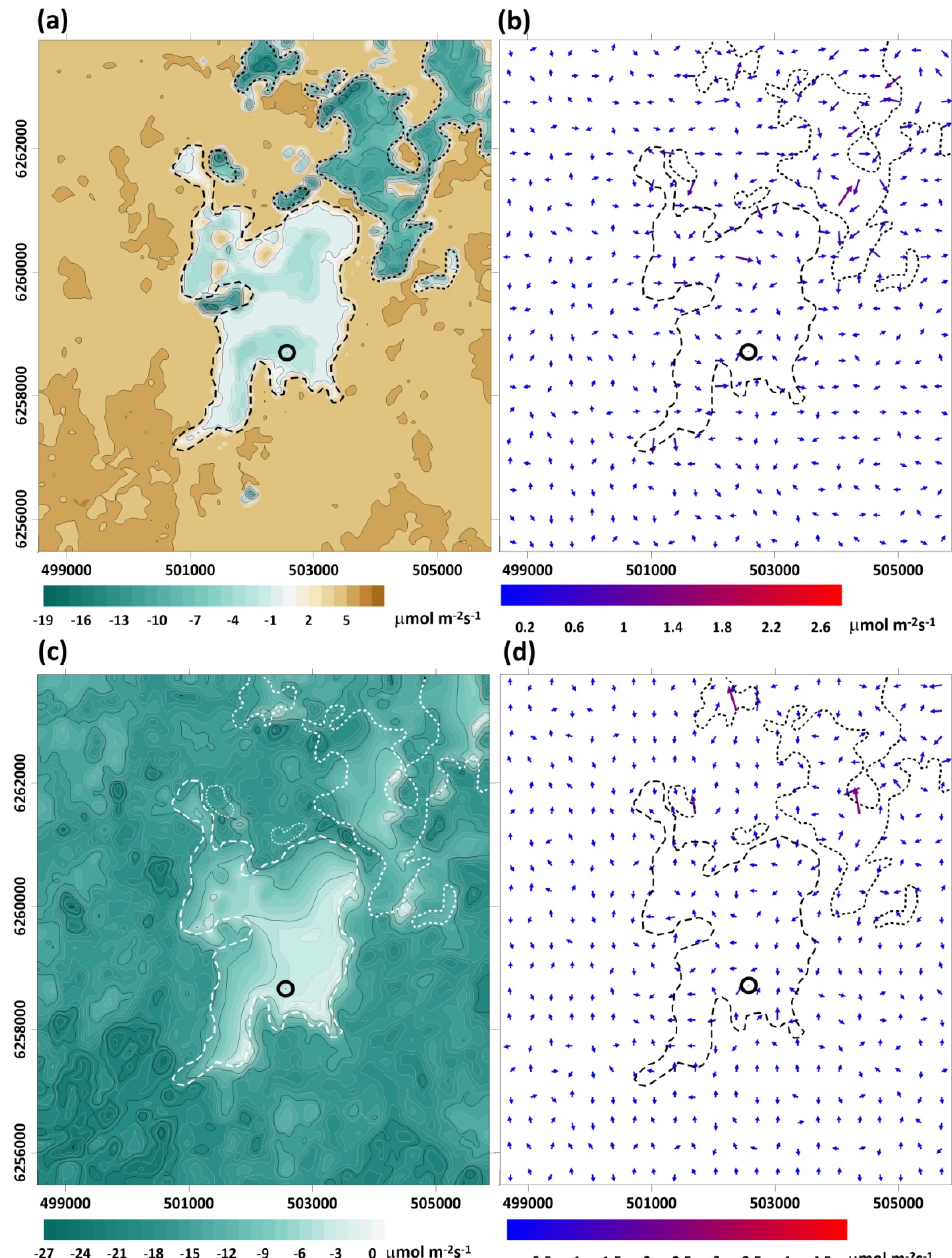
Figure 7. Modeled vertical ( a , c ) and horizontal ( b , d ) CO 2 fluxes (turbulent and advective) at the heights of 3 ( a , b ) and 30 ( c , d ) m above the ground. Calculations were performed using meteorological data at 13:03 on 28 June 2016. The medium-dashed line shows the peatland boundary. The short- dashed line shows the boundaries of abandoned lands with grassy vegetation and open places. The black circle indicates the location of the eddy covariance flux station. The coordinate system is Universal Transverse Mercator (UTM,